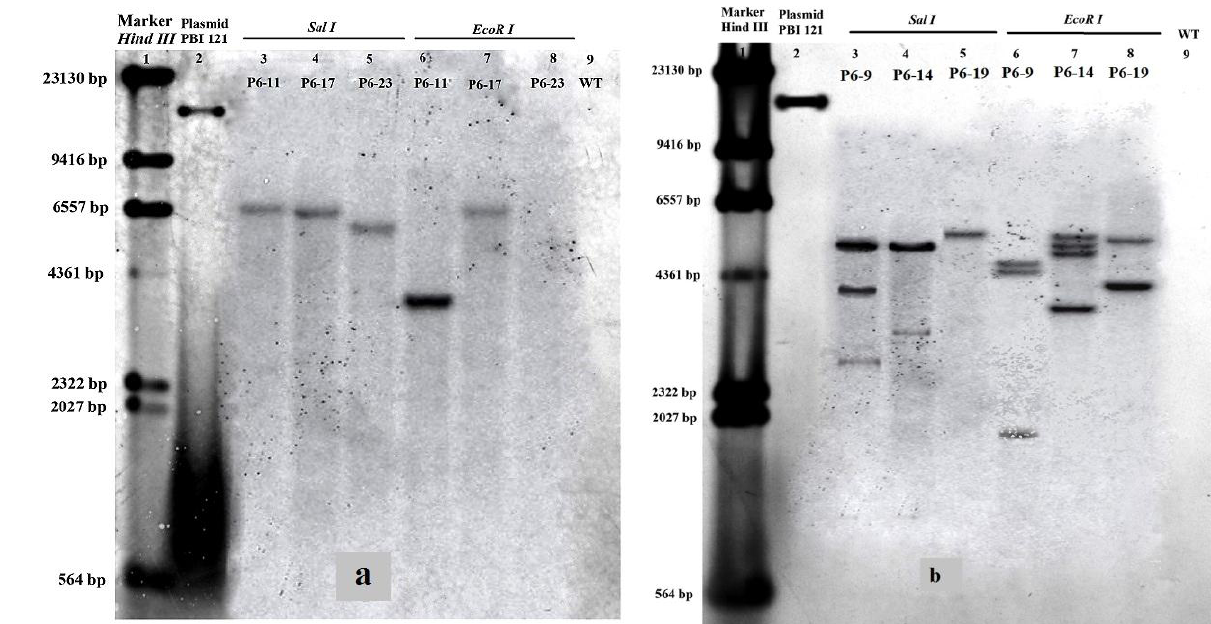
Lanes 6–8: the same genomic DNA digested with Eco RI; Lane 9: wild-type (WT) poplar; ( b ) Southern blot analysis of transgenic poplar lines generated with improved transformation